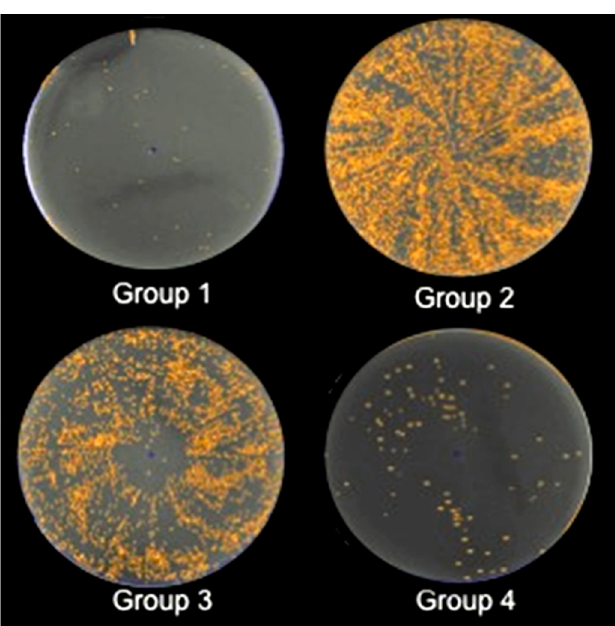
FIGURE 4 - LIVE/DEAD Test. Group “a” (GA), a positive control group treated with 800 µL of thioglycolate + 200 µL of NaOCl 5.25%; group “b” (GB), 1 mL of thioglycolate + laser irradiation (8 min, 33 sec), group “c” (GC), 1 mL δ -ALA (80 µg/mL)-thioglycolate solution; group “d” (GD), 1 mL of δ -ALA (80 µg/mL)-thioglycolate solution (5X10 7 cells/mL) + laser irradiation (8 min, 33 sec) .